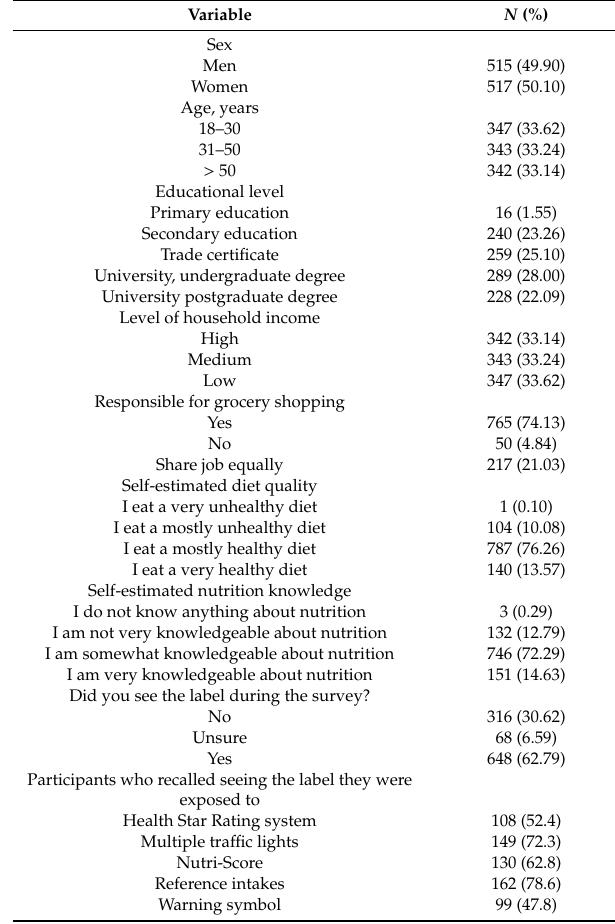
Table 1. Description of the population sample from Italy ( N = 1032